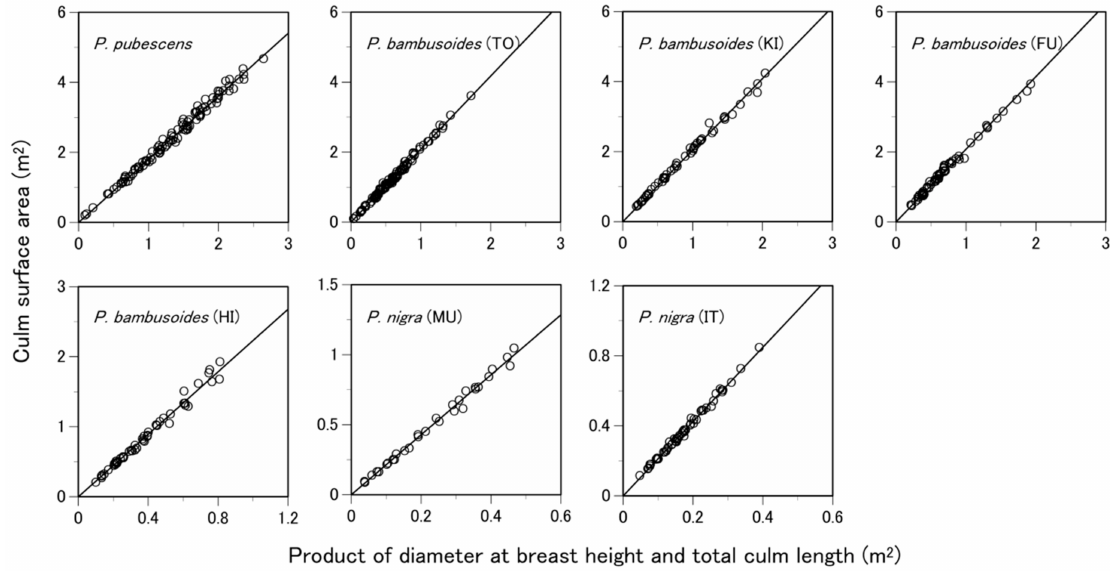
Figure 2. Relationship between culm surface area and product of diameter at breast height and total culm length for each species and site. The solid lines represent the linear equations detailed in Table